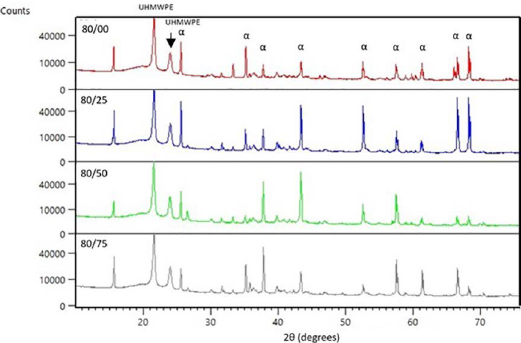
Figure 3. XRD patterns of A80/00, A80/25, A80/50, A80/75 samples.